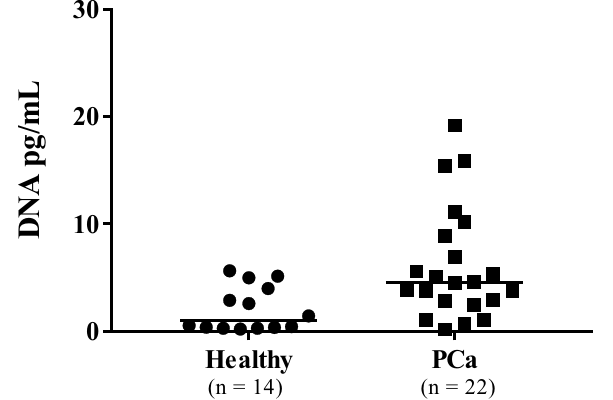
Figure 1. Quantification of plasma cfDNA in prostate cancer (PCa) patients measured by qPCR. Data are reported as medians (horizontal line). (*p < 0.05; Mann–Whitney U